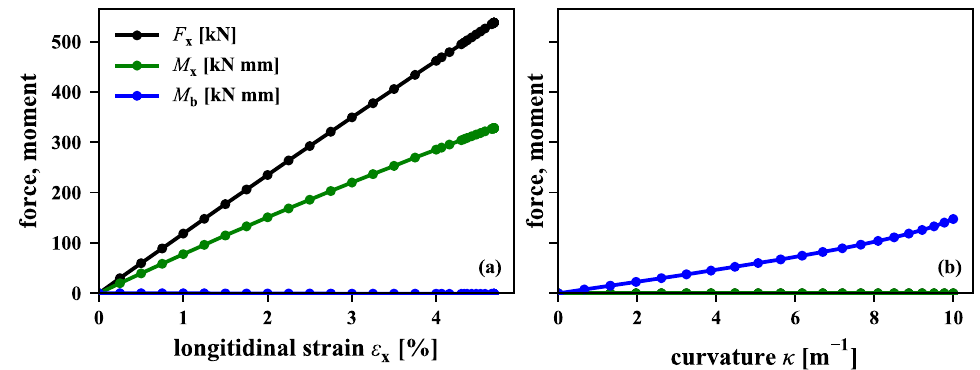
Figure 6. Tensile force, torsional moment, and bending moment plotted over ( a ) the longitudinal strain ε x and ( b ) the curvature κ of the seven-wire strand model for a mesh size of 0.5 mm and a strain 𝜀 (cid:2934) and ( b ) the curvature 𝜅 of the seven ‐ wire strand model for a mesh size of 0.5 mm and a relative cable length of relative cable length of 0.8.